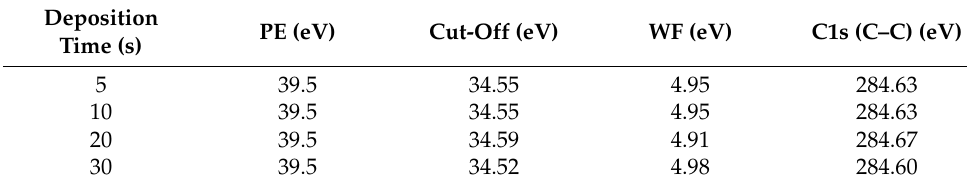
Figure 4. UPS spectra of prepared Ag–Ta thin films at different deposition times: ( a ) high-energy and ( b ) low-energy cut-off point. Table 1. Work function and C1s C–C reference binding energy of prepared Ag–Ta thin films at different deposition times.